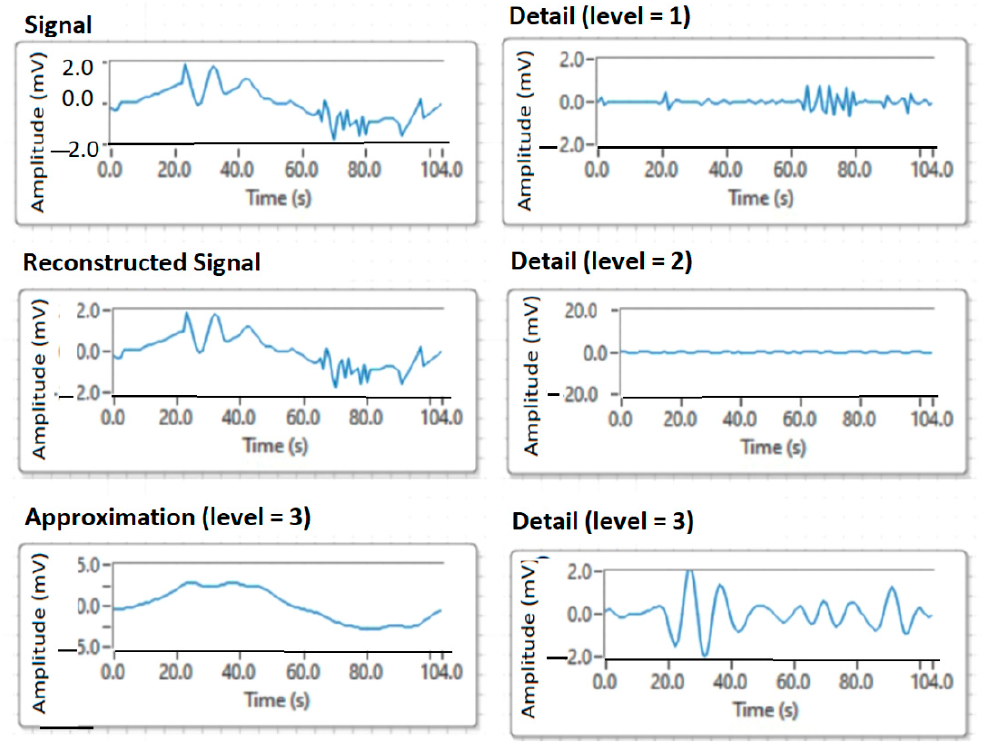
Figure 16. UWT analysis of the data network signal, using level 3 decomposition and ym6 function. Such values are obtained with the Higuchi method, for both types of